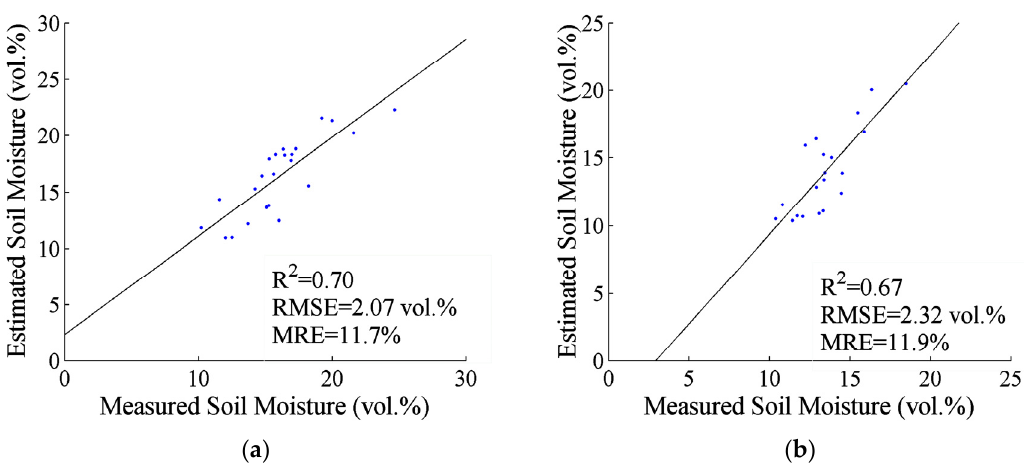
Figure 3. Comparisons between the measured and estimated soil moisture content using modified Dubois model: ( a ) Jiulong experimental area ( R 2 = 0.70, RMSE = 2.07 vol%); ( b ) Wannian experimental area ( R 2 = 0.67, RMSE = 2.32 vol%).